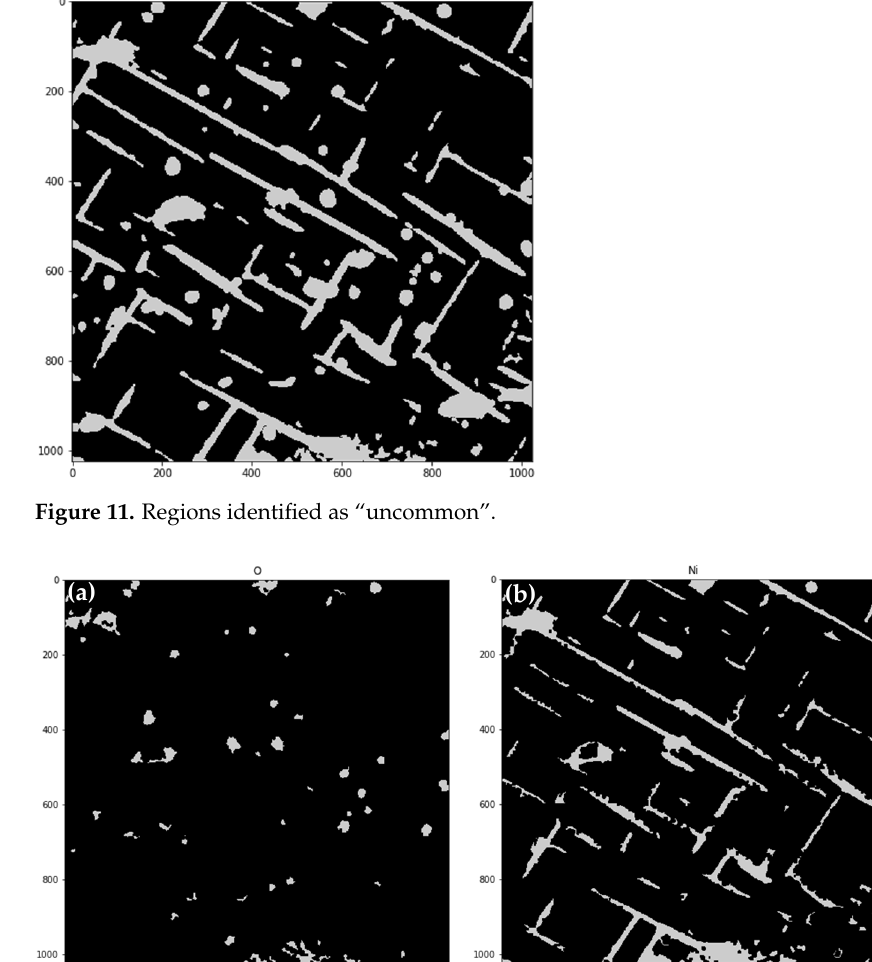
Figure 10. Summed and normalized intensities for images 3rd ( a ) and 4th ( b ) of final set of images.